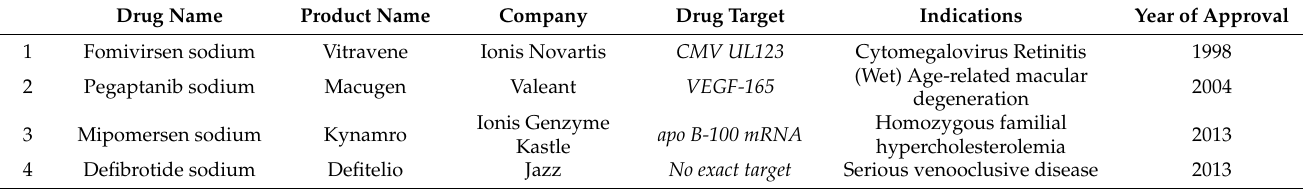
Table 1. Global nucleic acid drugs approved for